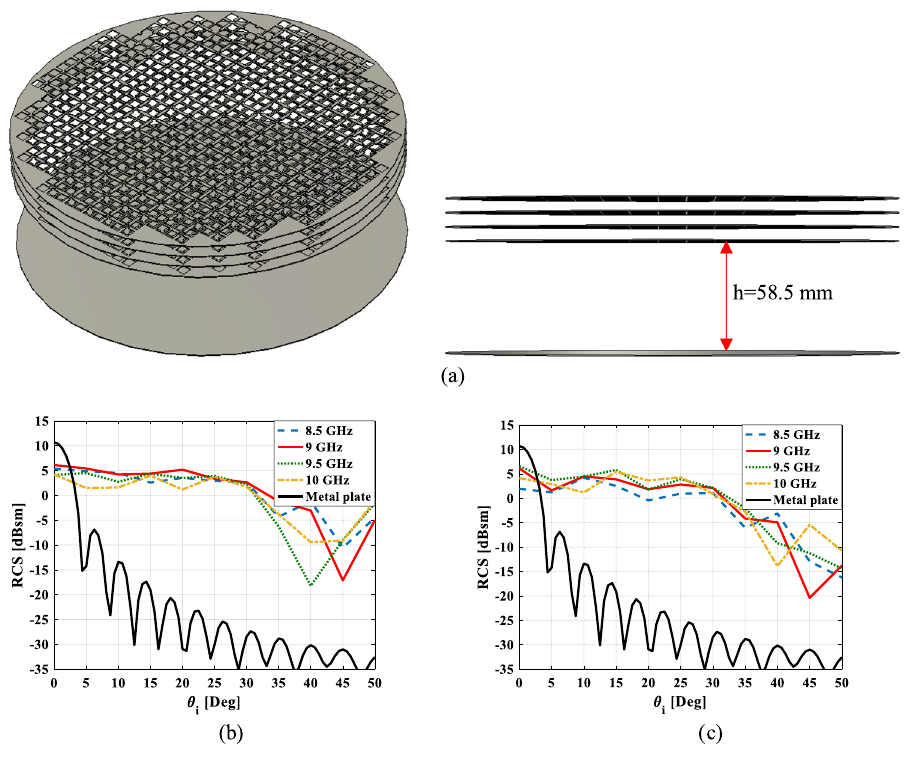
Figure 10. ( a ) The proposed retroreflector structure that is simulated in CST software, the monostatic RCS diagram versus incident angle at four frequencies for ( b ) TE and ( c ) TM polarization.